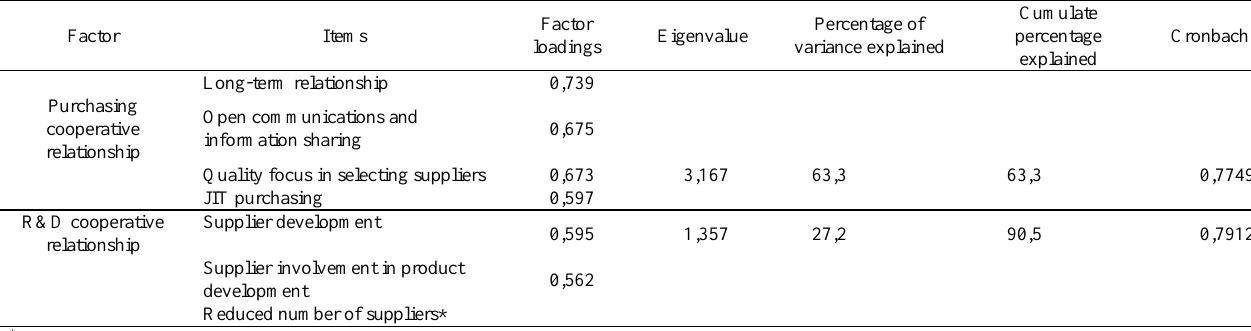
Table 2: Factor analysis of buyer-supplier relationships